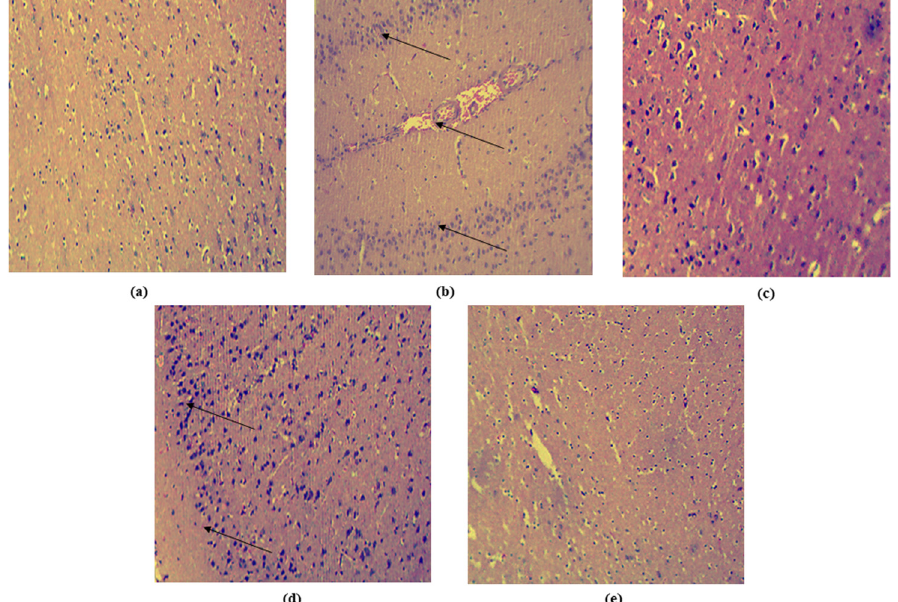
Figure 12. Histopathological images of brain hippocampi stained with hematoxylin and eosin under different treatments: ( a ) control, ( b ) PTZ (toxic control), ( c ) diazepam, ( d ) PIP suspension, and ( e ) PIP- SPL formulation. Arrows show neurodegeneration and neuronal cell death (10 ×